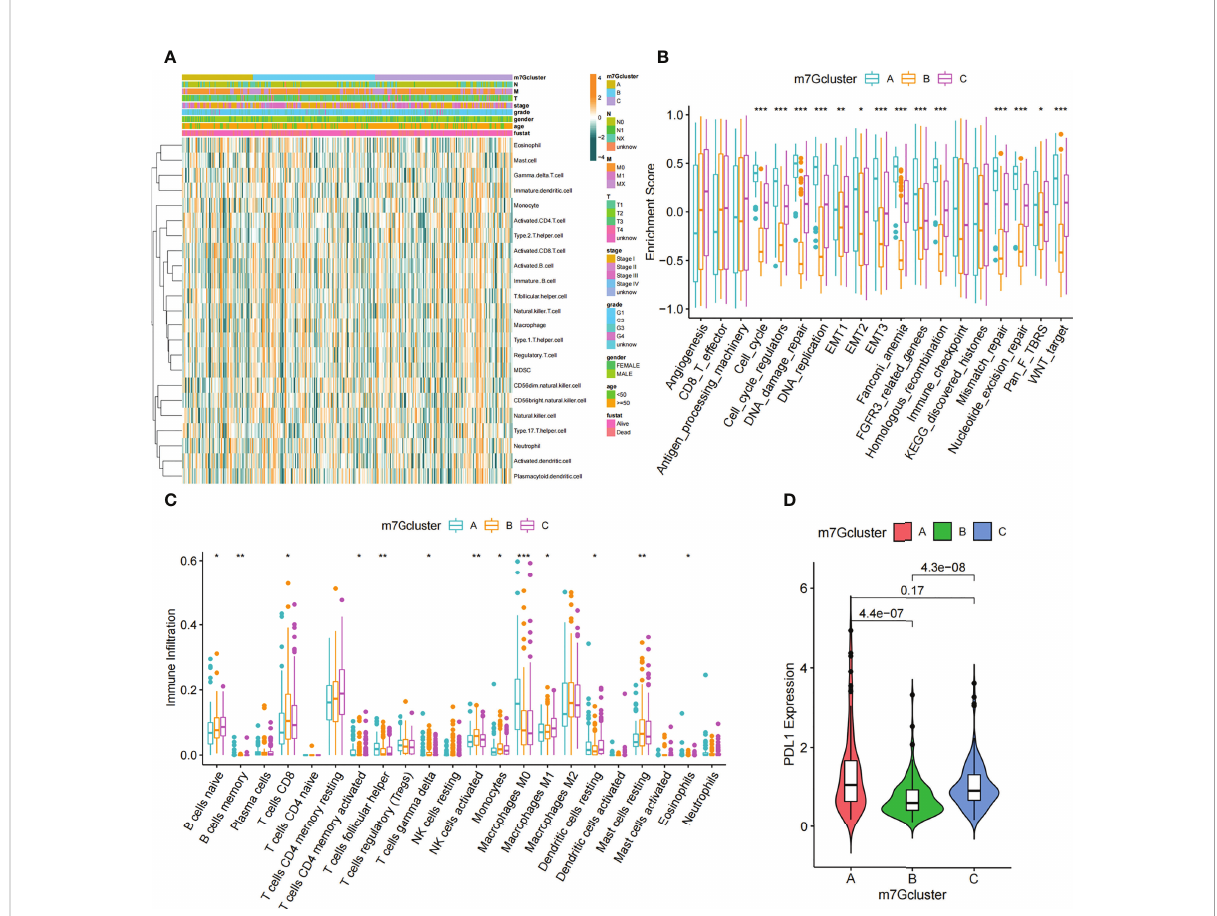
FIGURE 4 TME characteristics in different m 7 G modi fi cation patterns. (A) The heatmap used to visualize the in fi ltration of 23 immunocytes in three m 7 G clusters. Clinicopathological information including age, gender, tumor stage, and m 7 G cluster was shown in the annotation above. Yellow represented high expression of m 7 G regulators and green represented low expression. (B) In TCGA-LIHC cohort, m 7 G modi fi cation patterns were differentiated by distinct features. (immune-related signature, DNA repair-related signature and matrix-related signature). (C) Abundance of TME-in fi ltrated cells in the three m 7 G clusters. The line in the box indicated the median value and the scatter indicated the abnormal value. The upper and lower ends of the boxes indicated the interquartile range of values. (D) Comparison of PD-L1 expression levels of three m 7 G clusters. The whiskers encompassed 1.5 times the interquartile range. The upper and lower ends of the boxes indicated the interquartile range of values. Asterisks represent statistical p-values (*P < 0. 05; **P < 0. 01; ***P < 0.